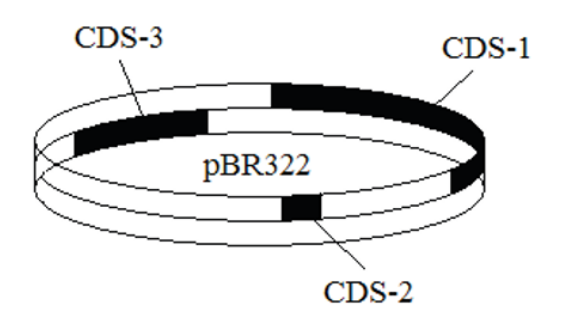
Fig. 1. Schematic picture of plasmid pBR322.. CDS-1, CDS-2 and CDS-3 are coding